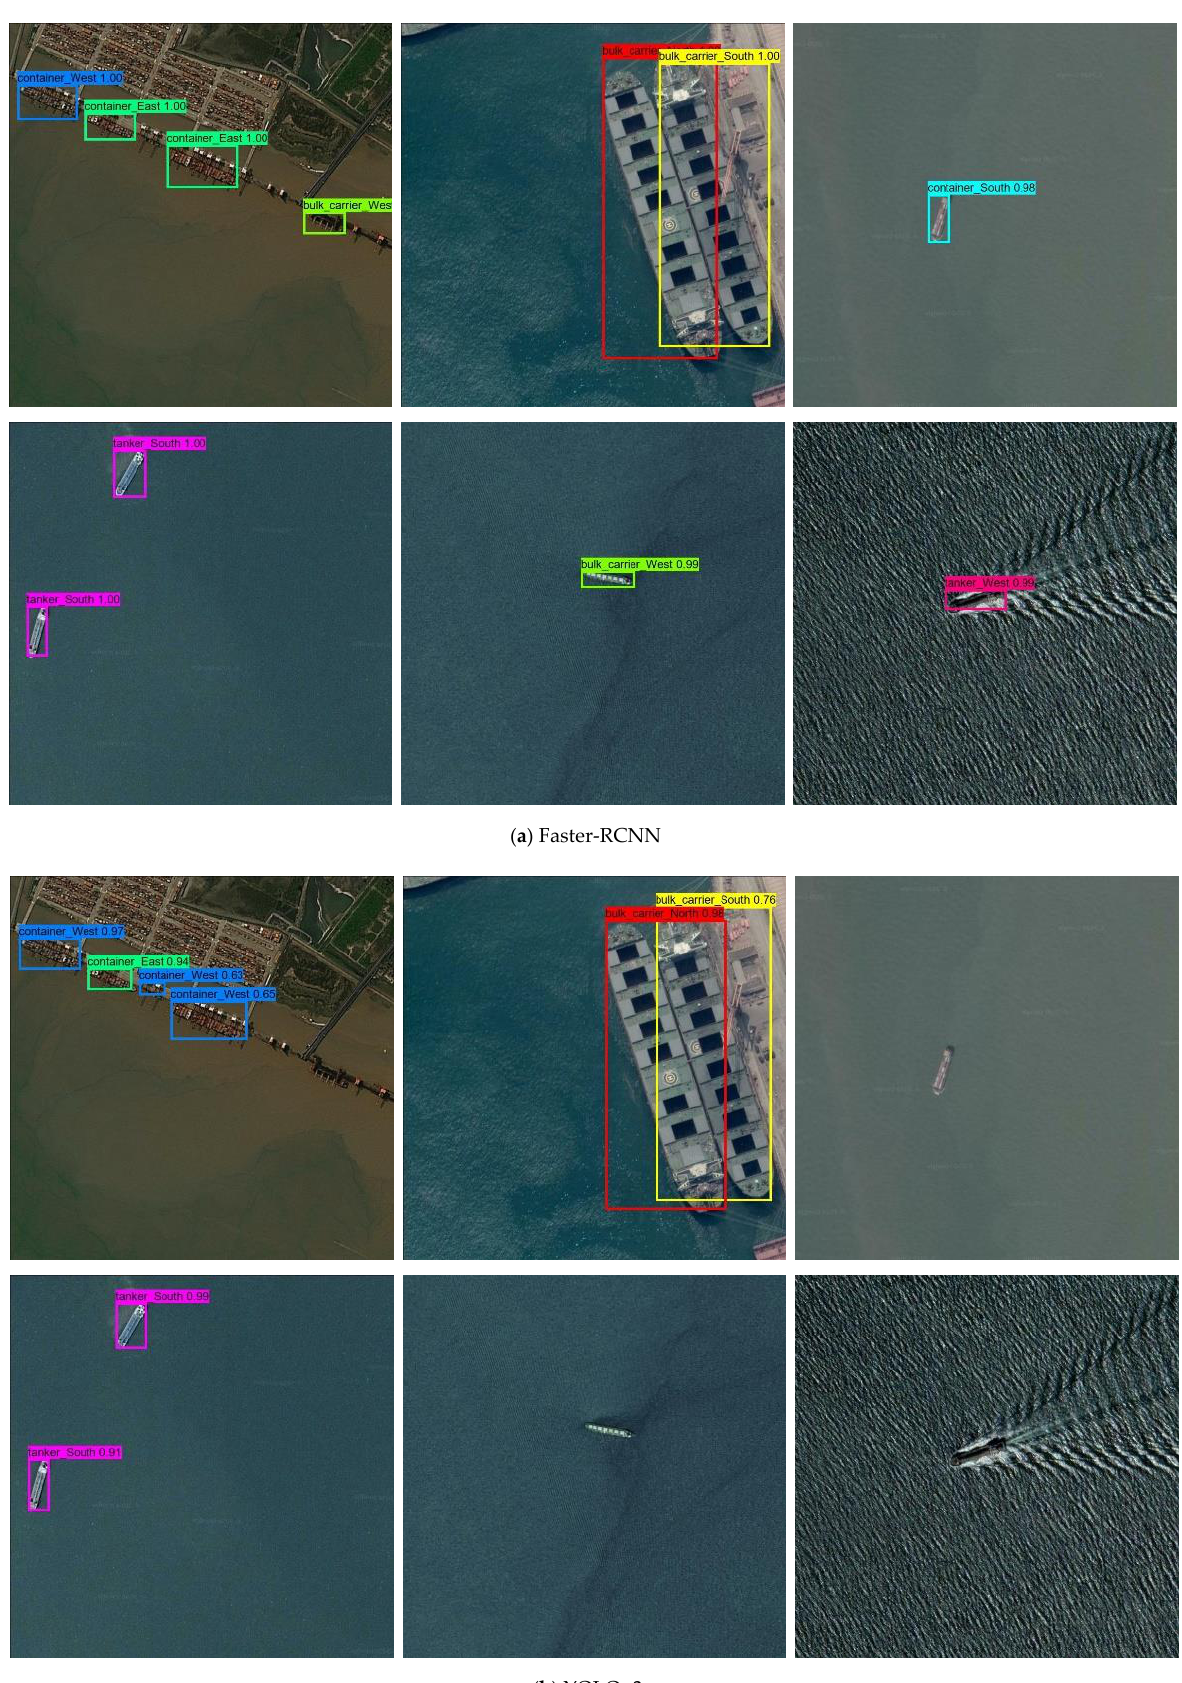
11 of 19 Table 5. Comparison of test performance between different models. Model